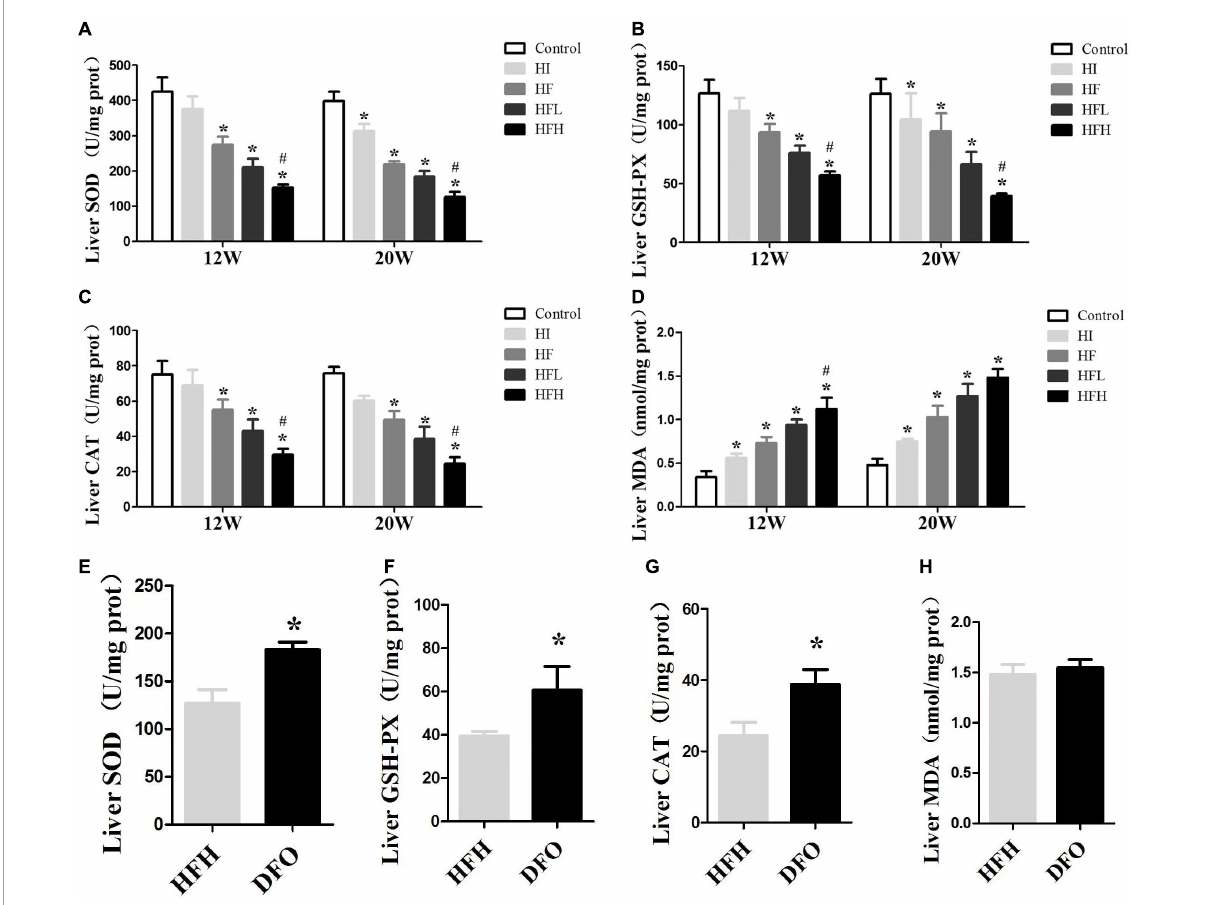
FIGURE4 Iron overload impaired antioxidant capacity and increased oxidative damage in HFD-induced NAFLD rats while DFO attenuates this effect. (A–D) The activities of SOD, GSH-PX, CAT and the levels of MDA in the liver of rats. * and # compared with control/high-fat group at the same time point, respectively, P < 0.05. (E–H) The activities of SOD, GSH-PX, CAT and the levels of MDA in the liver of rats after DFO treatment. * Compared with the HFH group, P <